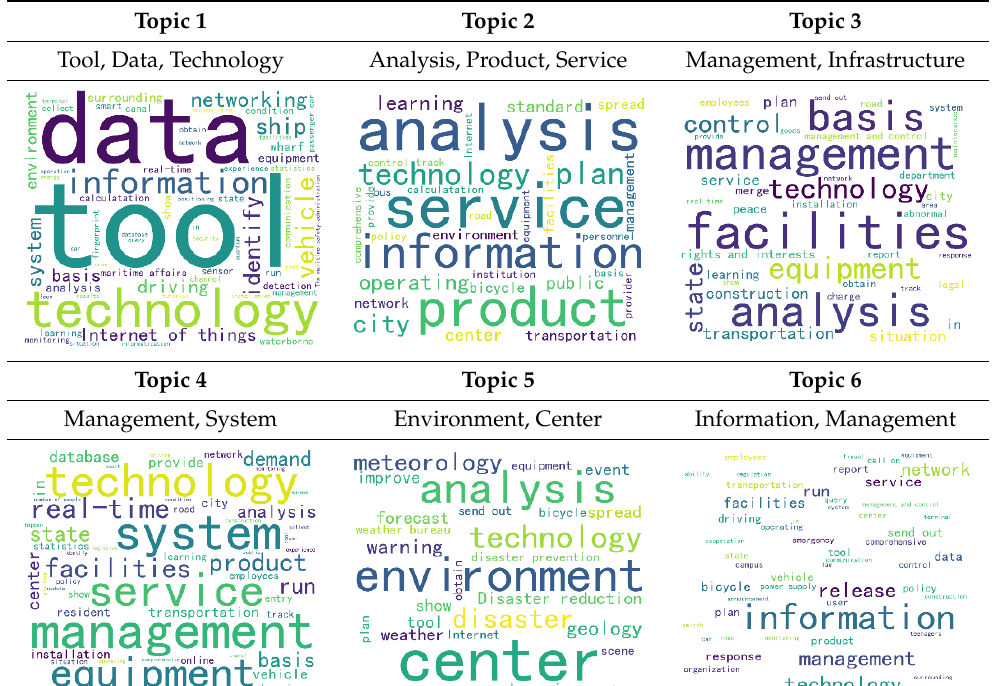
Table 2. Topic keyword distribution of each cluster.